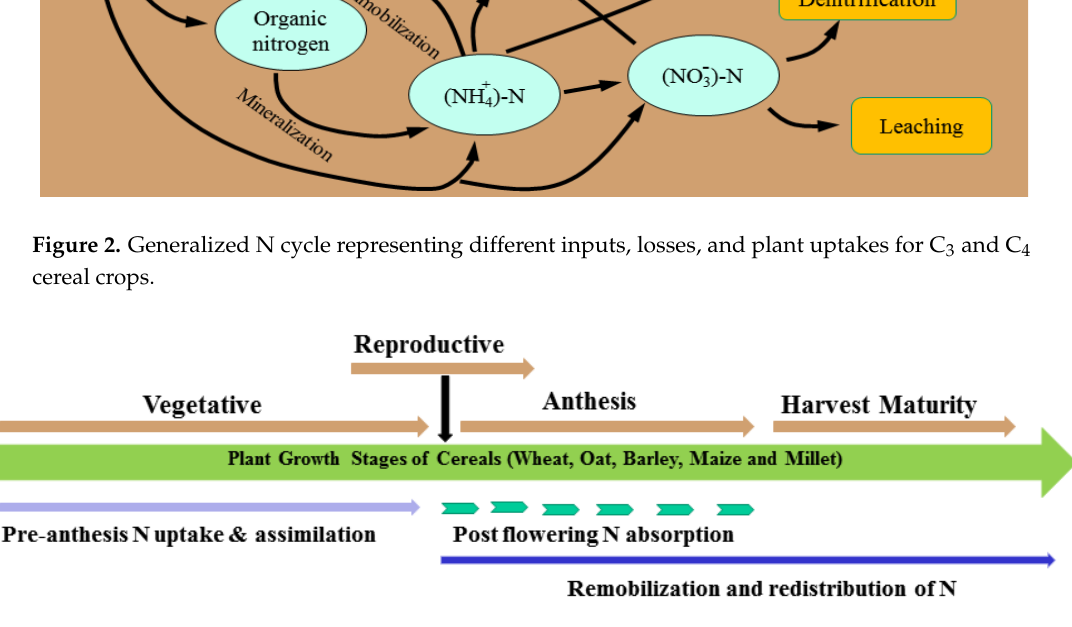
Figure 3. A simplistic schematic chart of N in C 3 and C 4 cereal crop plants representing different transformations that occur during the life span from sowing to harvesting of C 3 and C 4 cereal crops. The N uptake, absorption, remobilization, and redistribution are represented with different lines in relation to various growth stages. (Source: Modified and adapted from [54].)